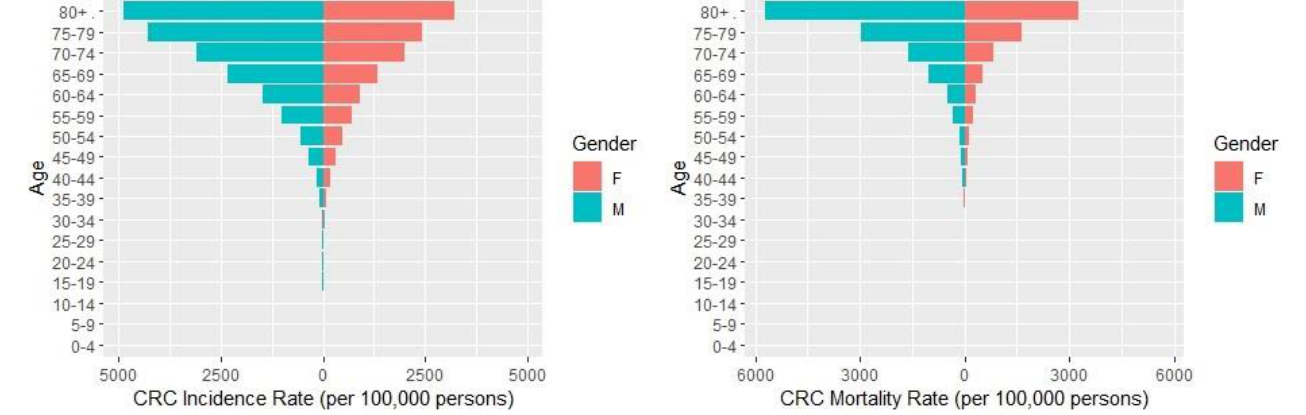
Figure 1. CRC incidence and mortality rates (per 100,000 persons) per gender and age group for the time period of 2000 to 2015.